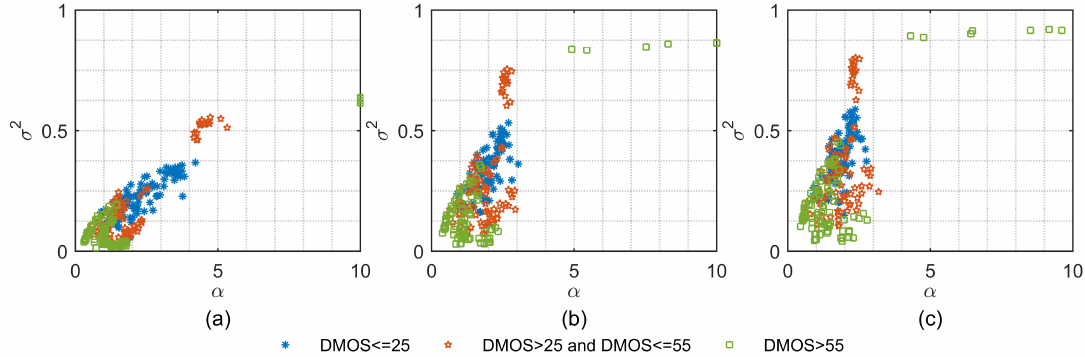
Figure 1. 2D scatter plots between GGD parameters α and σ 2 of the three NFMs, where each point in the scatter plots represents one distorted image in LIVE [28] database: ( a ) scatter plots for the first NFM; ( b ) scatter plots for the second NFM; and ( c ) scatter plots for the third